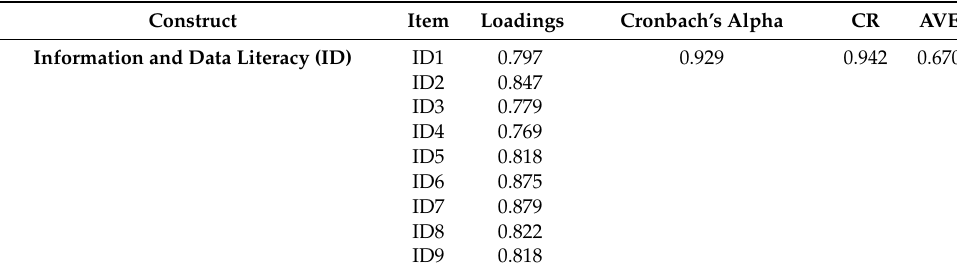
Table 1. Reliability and